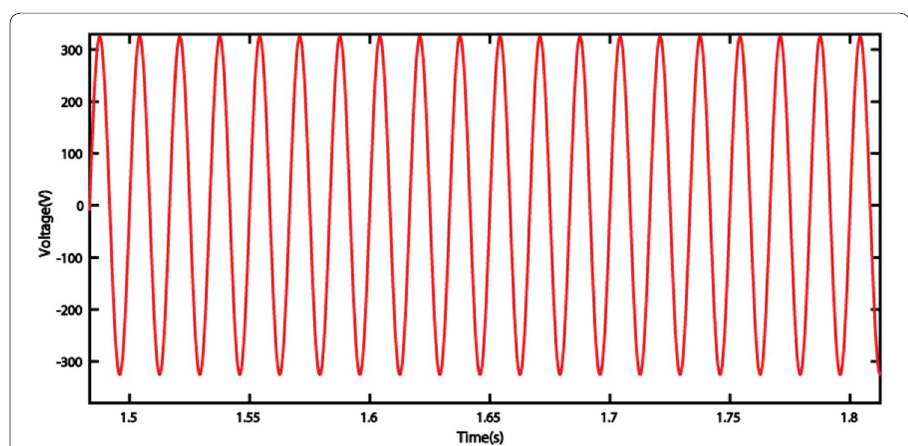
Fig. 17 Voltage at the